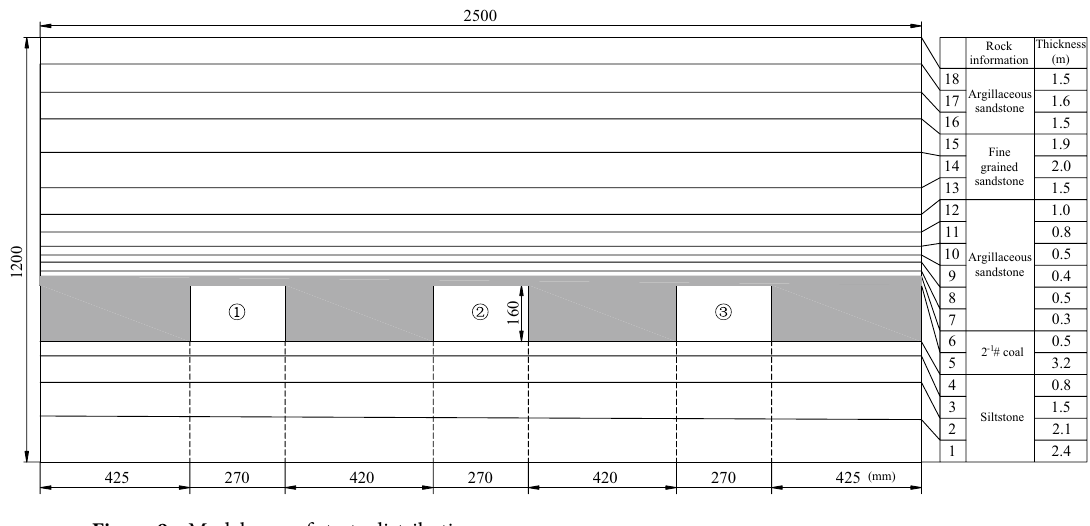
Figure 9. Model map of strata